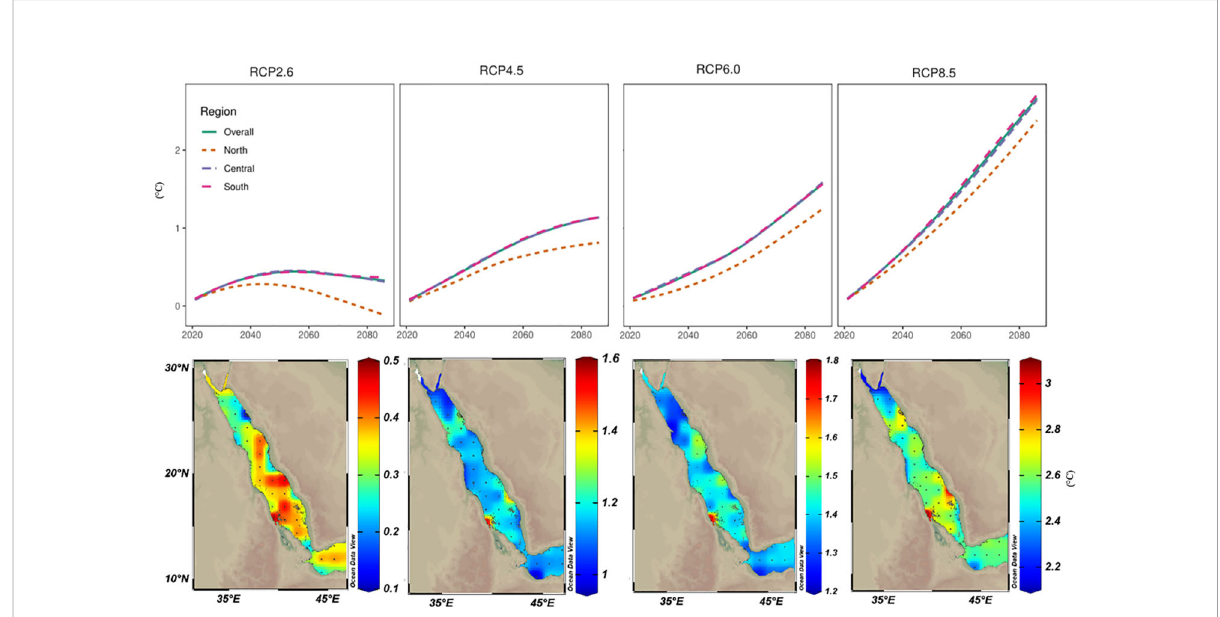
FIGURE 6 Projected warming trends for the year 2100 based on the CMIP5 ensemble mean models under various representative concentration pathway (RCP) scenarios. Projected sea surface temperature values ( D Tos= Tos2100 – Tos2006) were mapped to assess the spatial distribution of warming trends by 2100 along the Red Sea. Values were also averaged over the different regions of the Red Sea (North, Central, and South) and plotted over time to assess the temporal trends among Red Sea regions. Based on RCP2.6 (the least warming among all investigated scenarios), intriguingly the high values were restricted to the southern parts that may experience up to a 0.5°C increase in the SST by the end of the 21 st century. In RCP4.5 and RCP6.0, higher warming trends were projected in the central and southern regions. With the business-as-usual scenario (i.e., RCP8.5), warming in the northern region is projected to be less (2.5°C) than the projected warming in the central and southern (3°C) regions with values less than the reported current warming values using TSE